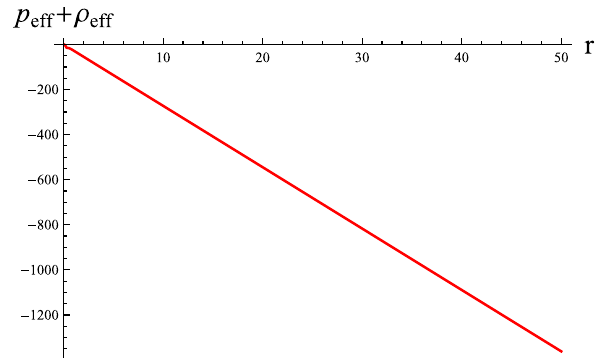
Fig. 12 Evolution of effective NEC versus r for w = − 1